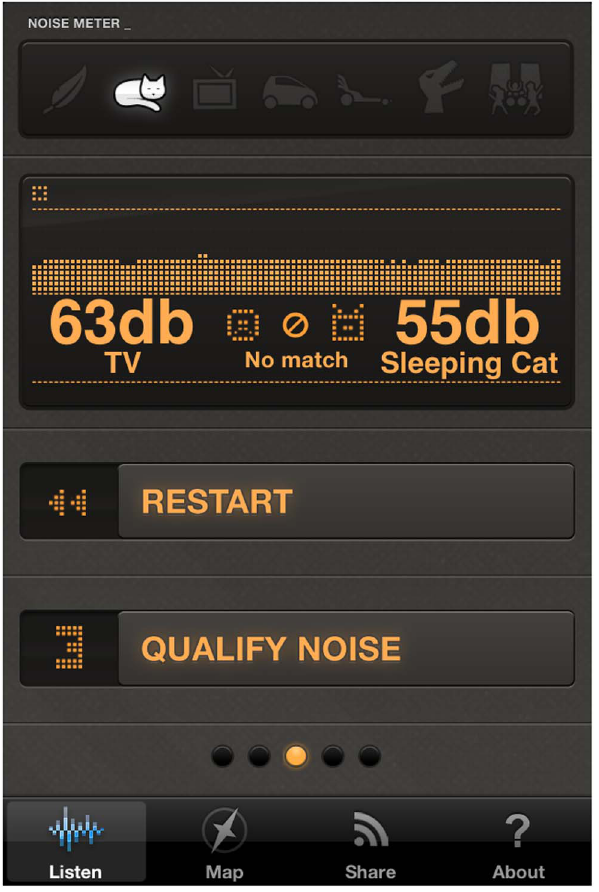
Figure 2. Perception screen for WideNoise Plus mobile